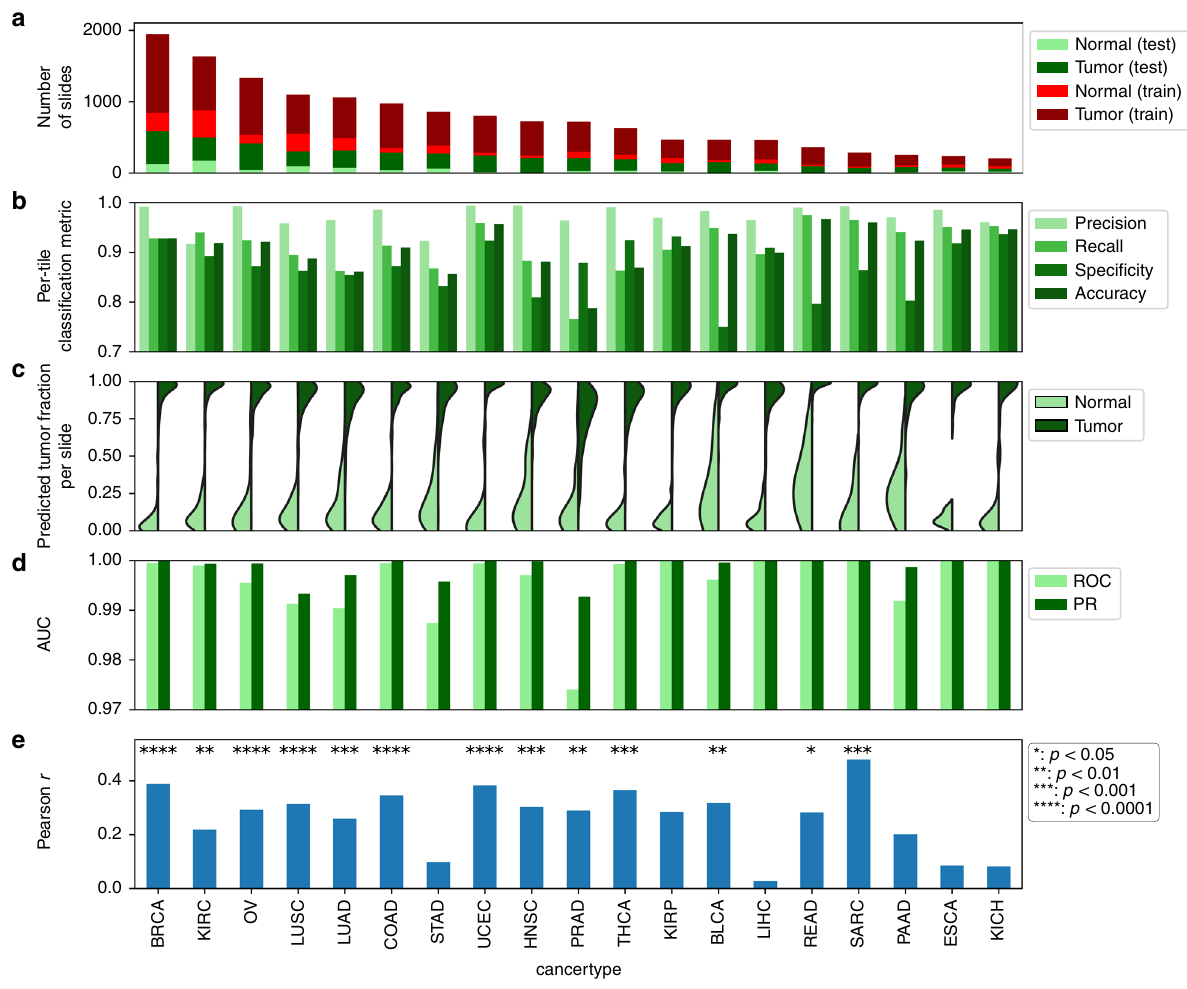
Fig. 2 Tumor/normal classi fi cation using CNNs. a Numbers of tumor and normal slides in test and training sets. b Per-tile classi fi cation metrics. Tile-level test set sizes are provided in Supplementary Data 3. c Fraction of tiles predicted to be tumor within each slide. d Per-slide AUC values for tumor/normal classi fi cation for ROC and precision-recall curve (PR). e Pearson correlation coef fi cients between predicted and pathologist evaluation of tumor purity. P values are based on the permutation test of the dependent variable after Bonferroni correction across all cancer types. Raw and adjusted P values are provided in Supplementary Data